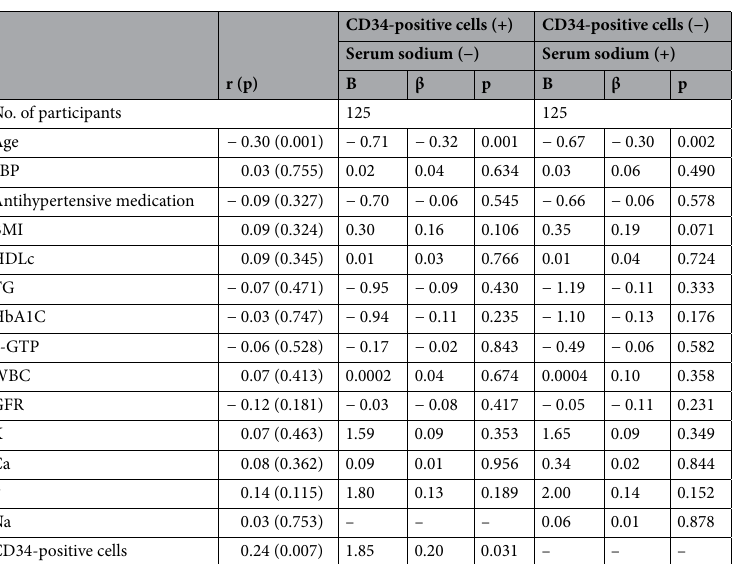
Table 3. Results of simple correlation analysis and multiple linear regression analysis for subjects with hypertension of handgrips strength with relevant factors adjusted for confounding factors. SBP systolic blood standardized parameter estimate, p p value for multivariable linear regression models, Triglycerides γ-GTP and CD34-positive cell were calculated as logarithm